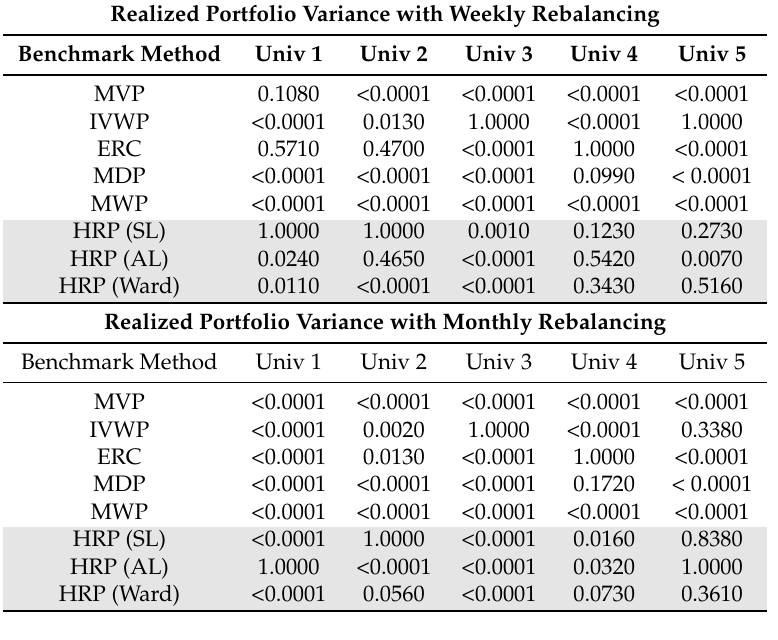
Table A3. The out-of-sample realized annual volatilities for different rebalancing horizons when DCC GARCH is used for covariance